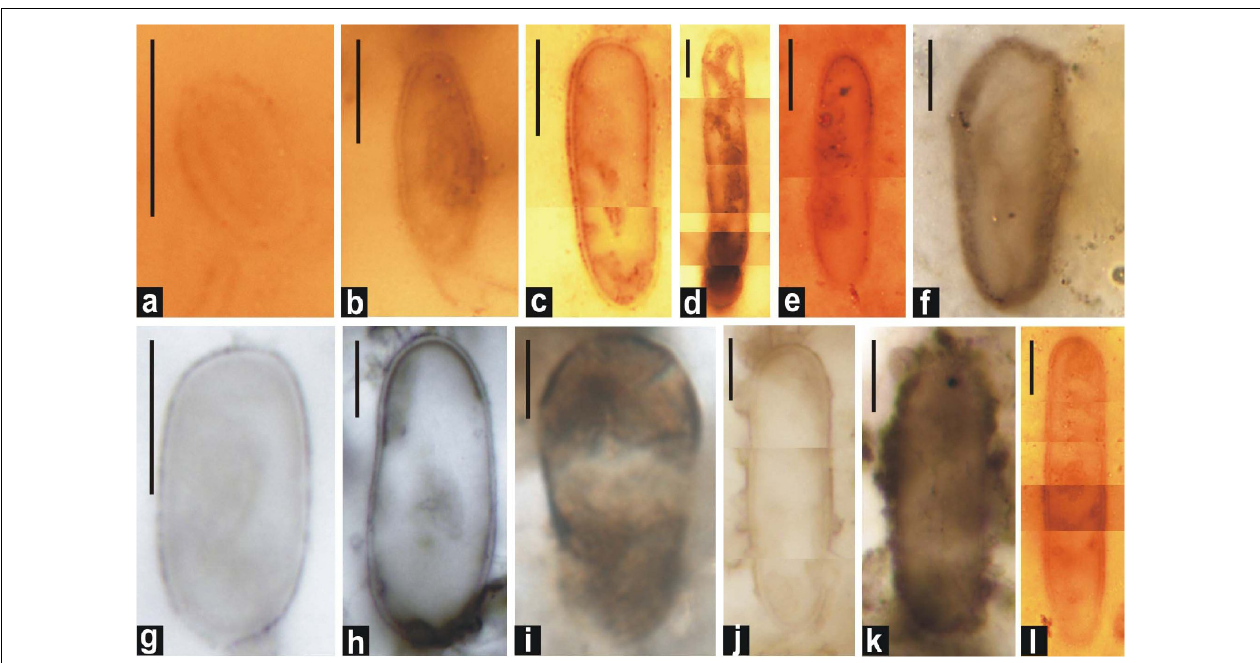
FIGURE 6 | Photomicrographs of double-walled akinetes formed in petrographic thin sections of black chert. (d,f,h–j, and l) : A . bactroformis ; (c,k) A . major ; (a,b,e, and g) : A . minor . Scale bar = 10 µ